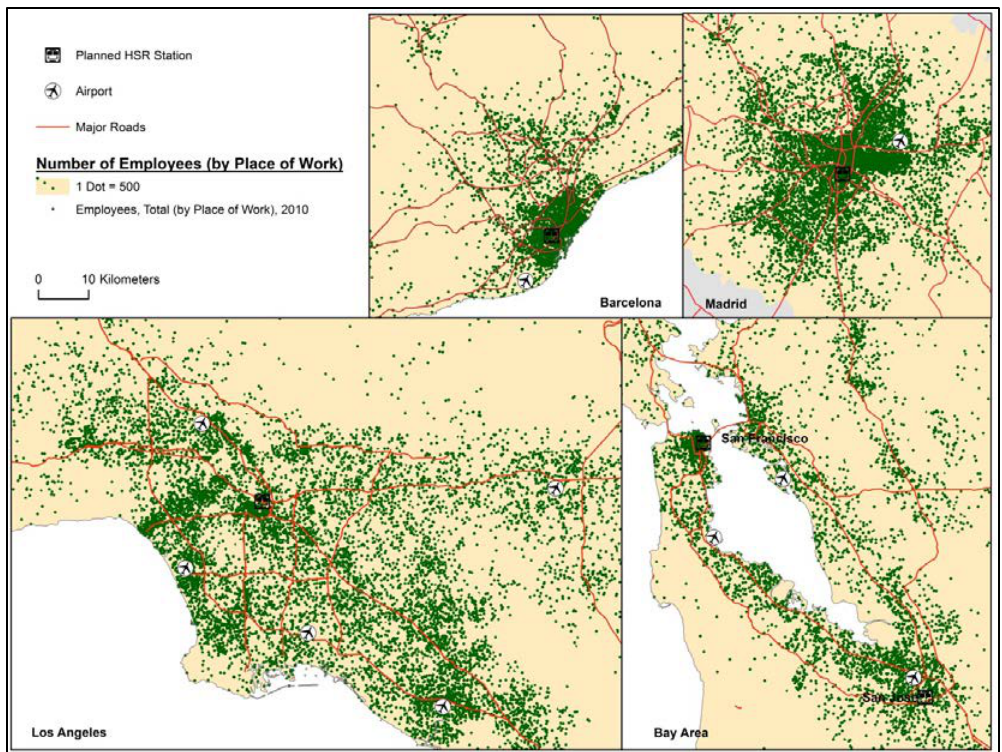
Figure 4 Employment Comparisons 2: Barcelona, Madrid, Los Angeles and San Francisco Bay